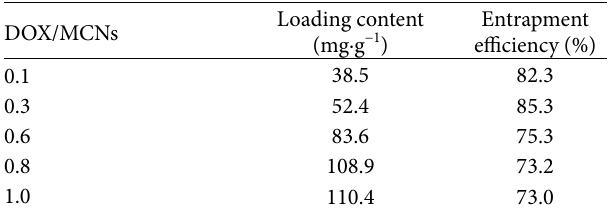
Table 1: DOX loading content and entrapment efficiency of the MCNs.